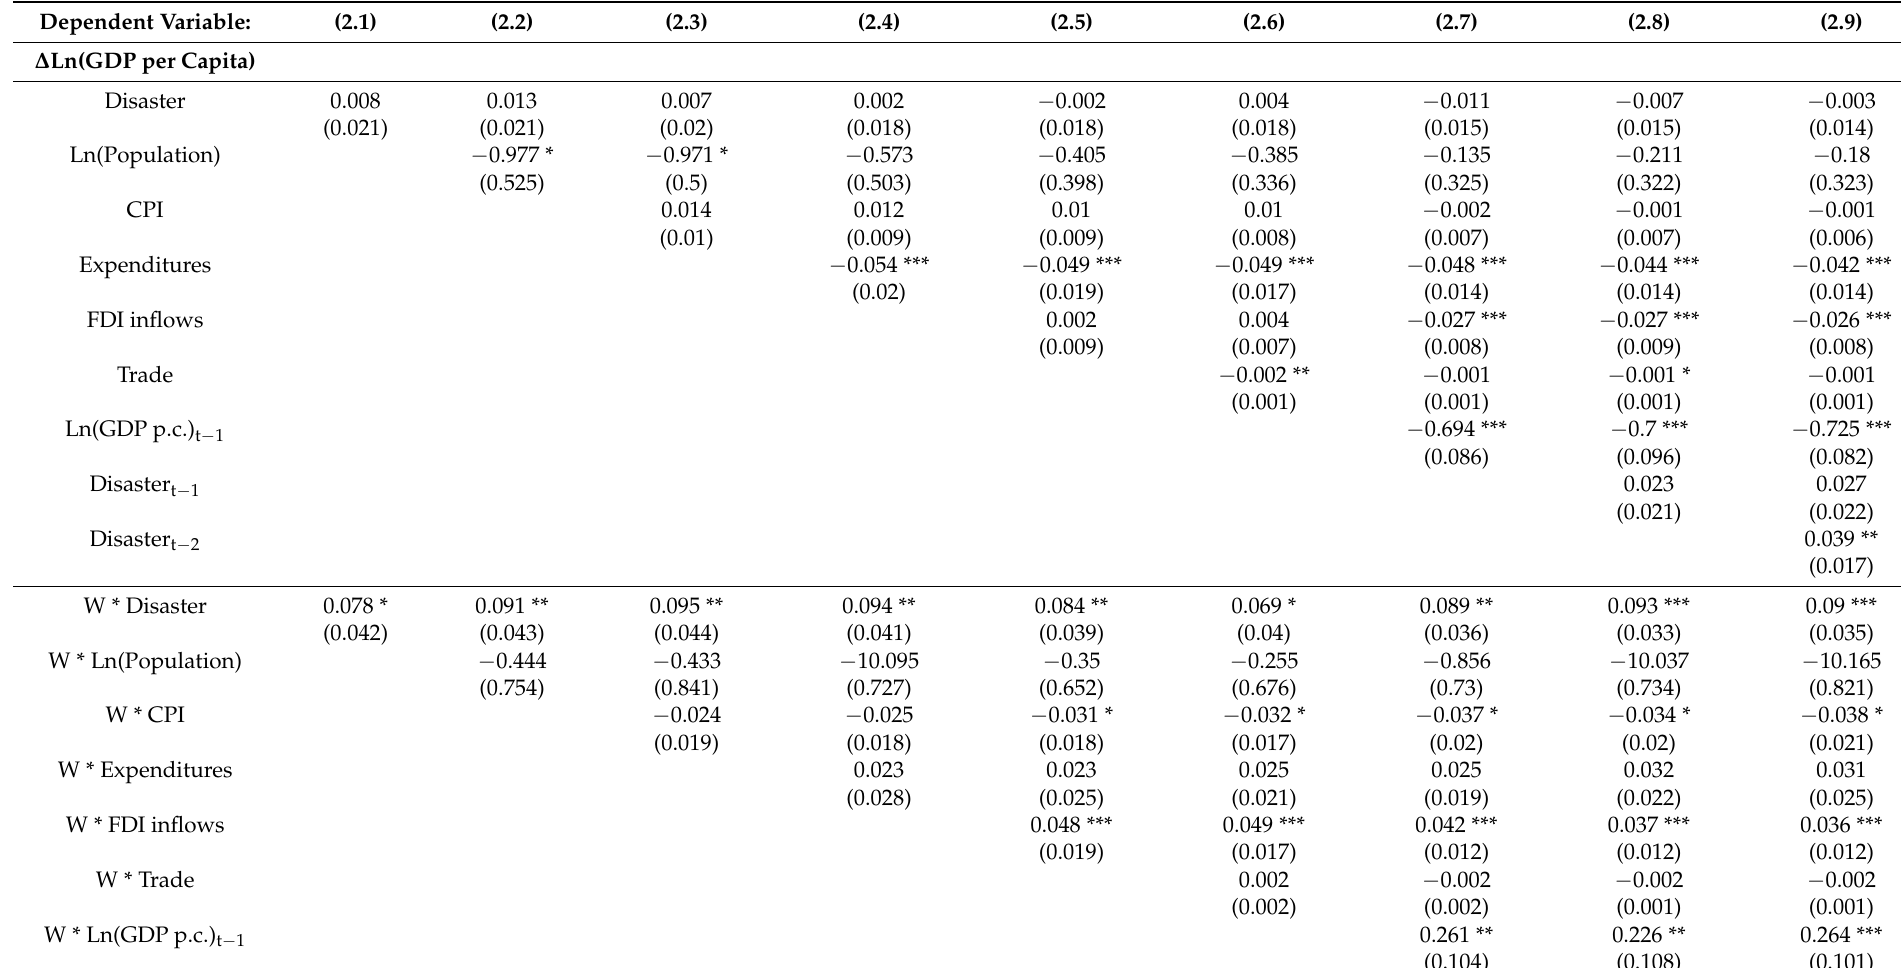
Table 2. Results of spatial Durbin panel model (SDM) using maximum likelihood estimations (MLEs, with natural disaster dummy